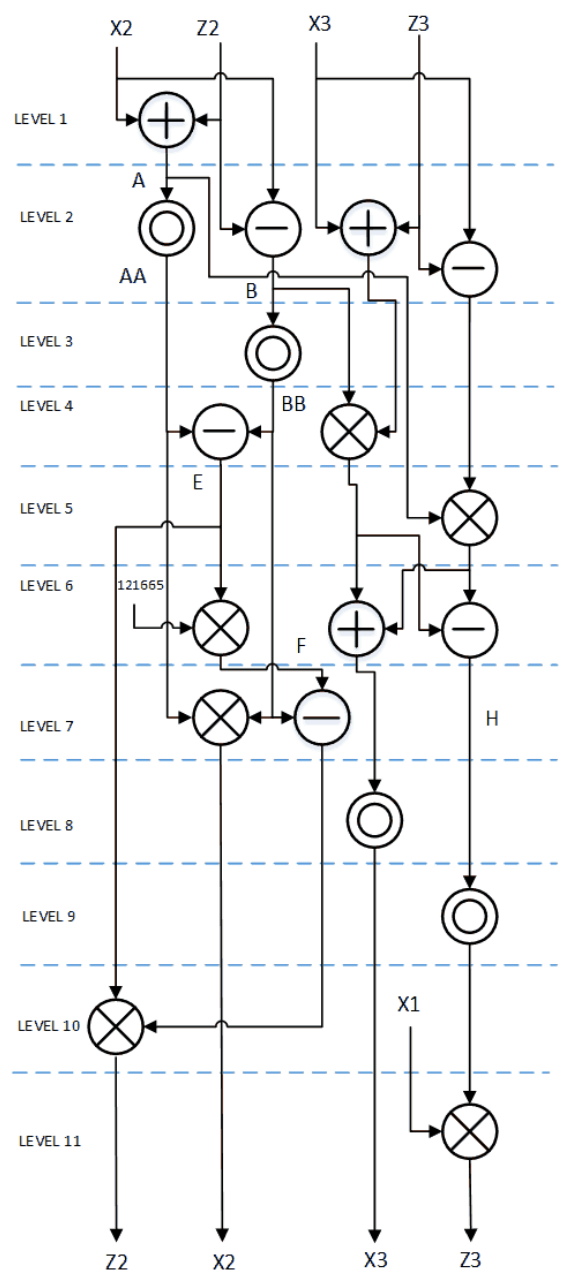
Figure 3. CURVE25519 differential point addition and point doubling flow diagram.